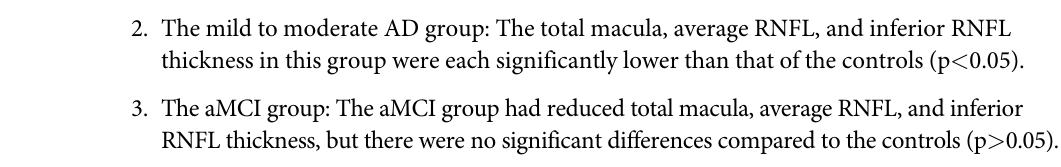
Fig 3. These diagrams represent the results of retinal thicknesses observed in the four groups. � Statistically significant difference compared with the controls (P < 0.05).